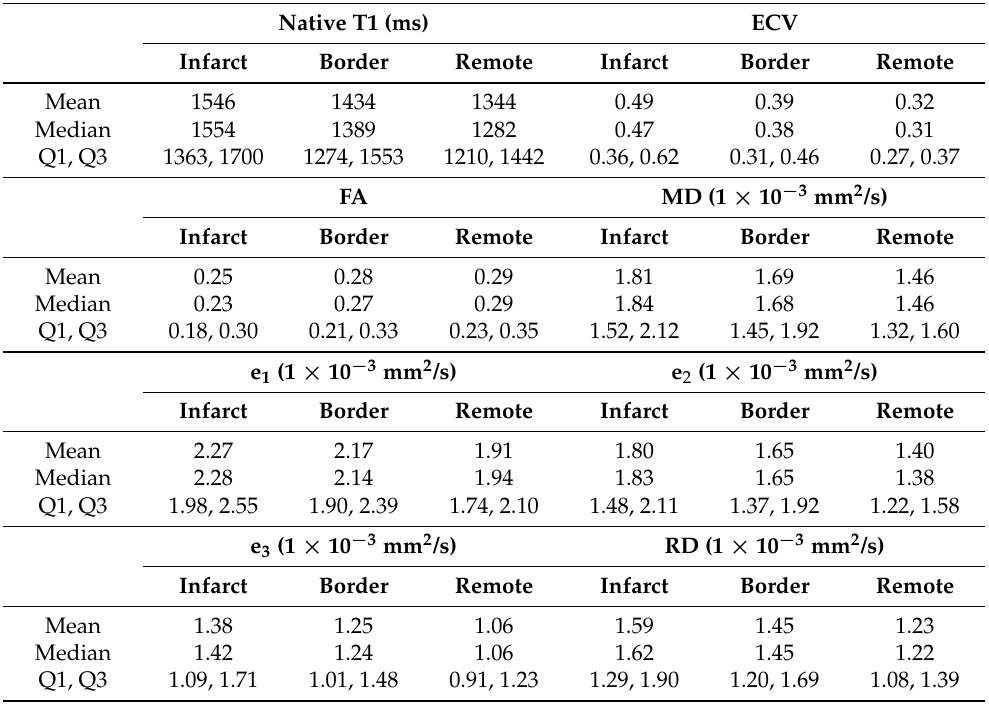
Table 1. Overall mean, median, and Q1–Q3 computed across all subjects for native T1, ECV, FA, MD, diffusion tensor eigenvalues, and RD in the infarct, border, and remote regions. Native T1 (ms) ECV Infarct Border Remote Infarct Border Remote Mean